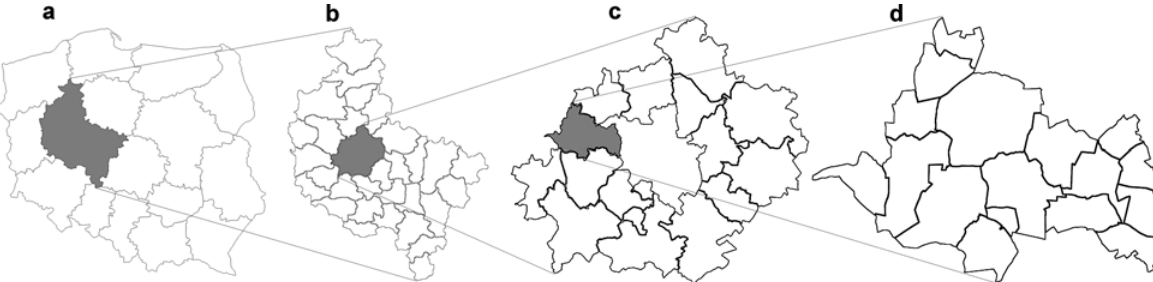
Fig. 1. Tarnowo Podgórne commune in the administrative division of Poland: (a) Poland/ voivodeships; (b) Wielkopolska/ poviats; (c) Poznań poviat/ communes; (d) Tarnowo Podgórne commune/ villages ( sołectwa ). Source: own